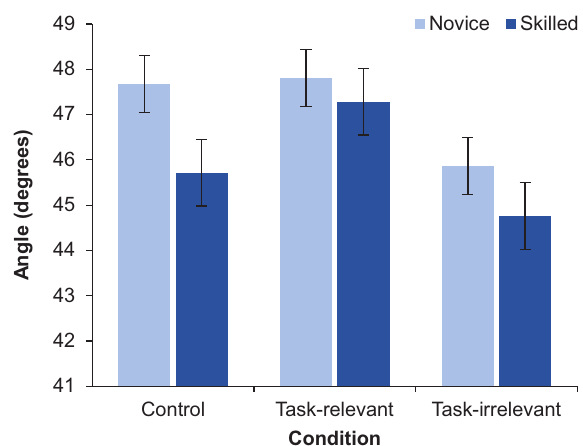
Figure 2. Initial knee angle (mean) with different at- tentional cues in novice and skilled participants. Error bars represent standard